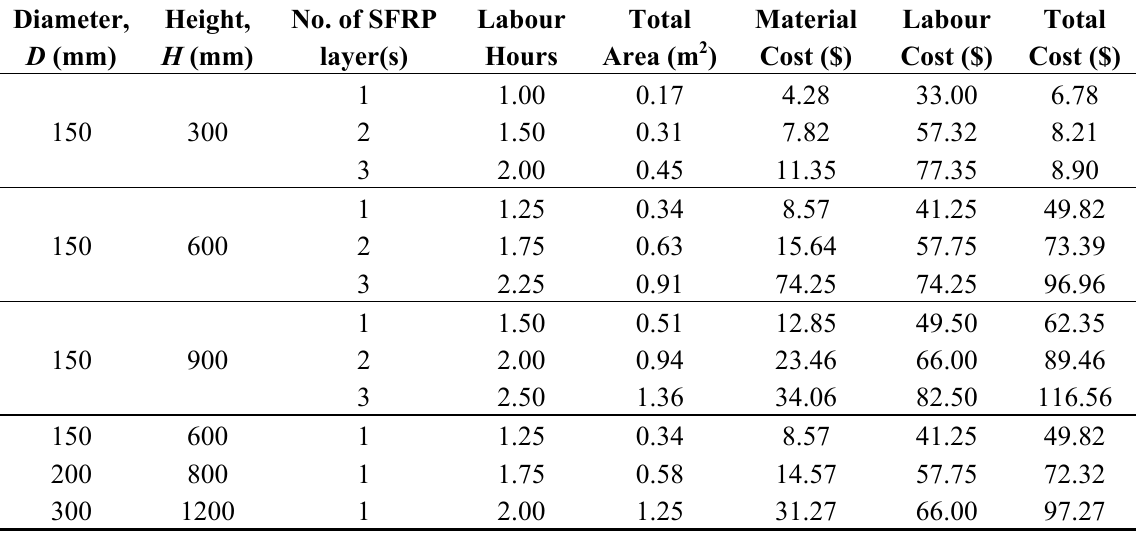
Table 4. Summary of the material, labour and the total cost of the SFRP confined concrete columns. Diameter, Height, Labour D (mm)